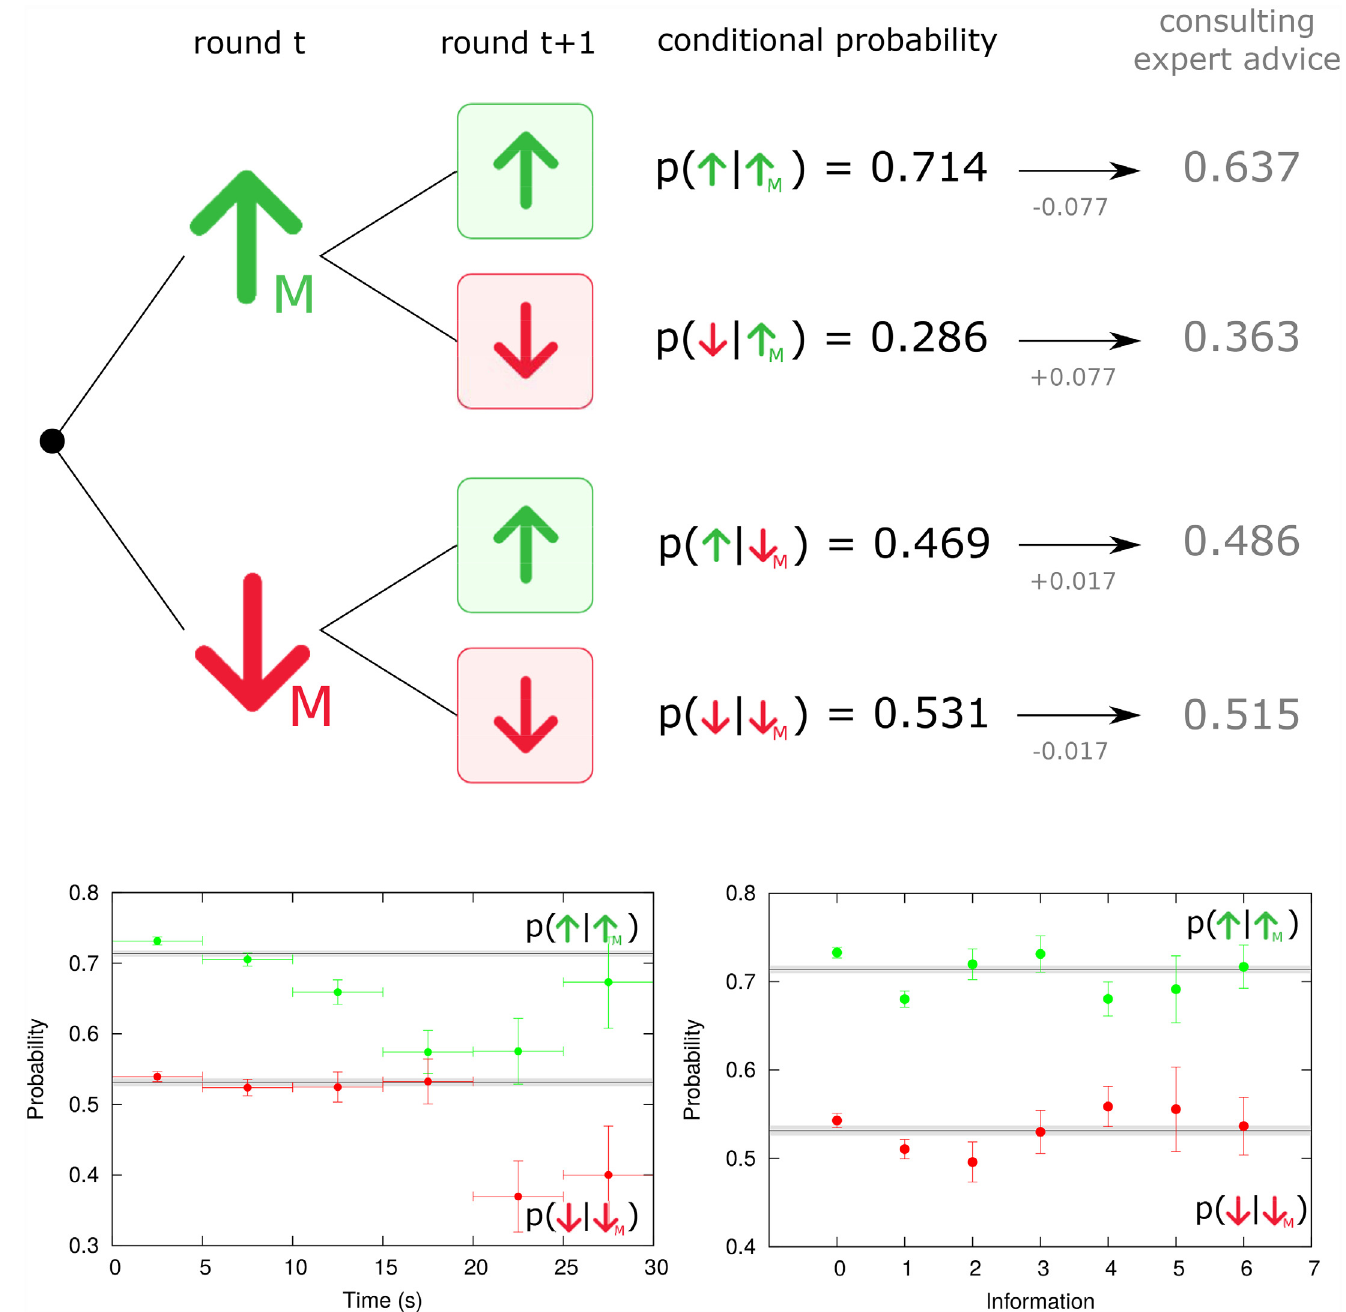
Fig 3. Decision conditioned to market: the Market Imitation emerging strategy. Empirical conditional probabilities of guessing whether market will go up or down are positively correlated with market behavior in the previous round. Participants tend to mimic market movement and this behavior is specially important when market went up ( p ( " | " M ) = 0.714 ± 0.005). The effect is however sensitively diminished when subject consults expert ’ s advice (0.637). (down left) The time spent to make a decision plays a significant role when a participant guesses that market will go “ up ” (green) in contrast with case when a participant guesses that market will go “ down ” (red). (down right) Checking an additional type of information also tends to diminish conditional probabilities but when a participant consults more information, the participant mimics market movement again. Horizontal lines in bottom plots provide aggregated results and shadows their error bars. Error bars represent the Standard Deviation of a binomial distribution.